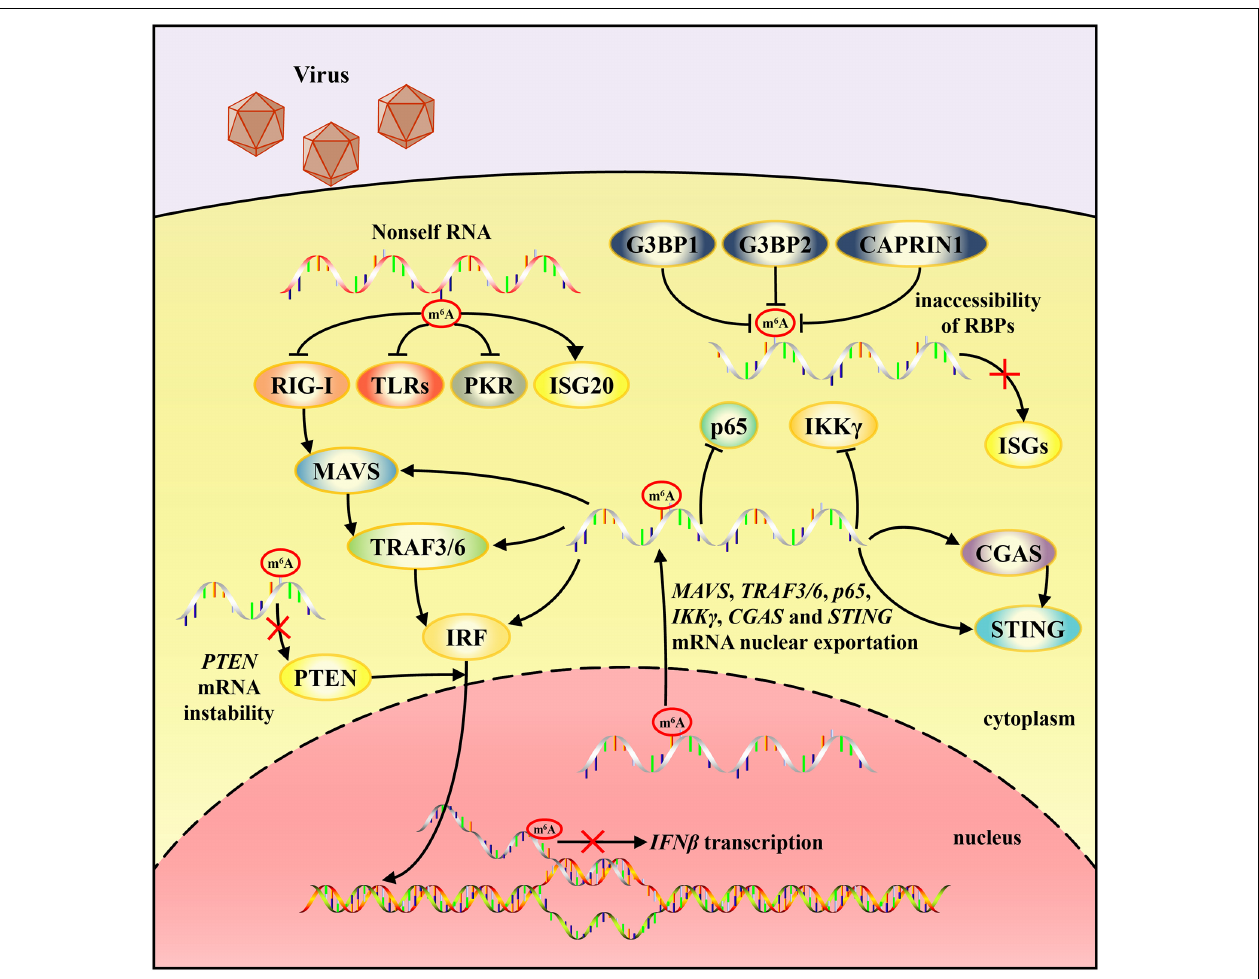
FIGURE 1 | Schematic diagram of mechanisms by which m 6 A modification regulates non-self RNA recognition and innate immune responses. m 6 A modification in exogenous RNA prevent it from being identified by RNA sensors except for ISG20. Nuclear exportation of MAVS , TRAF3/6 , p65 , IKK γ , CGAS , and STING mRNA can be accelerated by m 6 A modification. m 6 A decoration may be an obstacle to IFN β and ISGs expression. PTEN , p65 and IKK γ mRNA instability can also be attributed to m 6 A